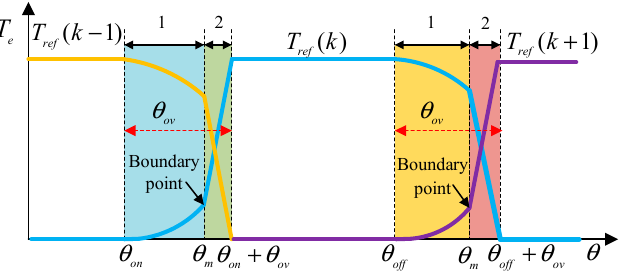
Figure 7. Torque reference of NUTSF.